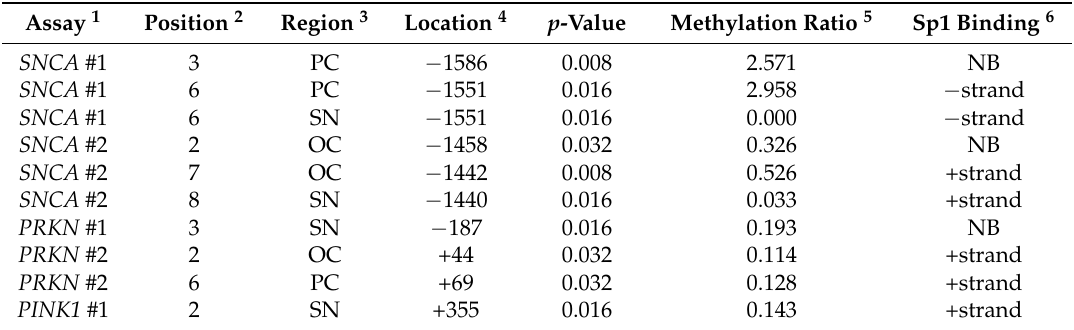
Table 1. Statistically significant results for the comparison of DNA methylation levels between controls and PD patients ( p <